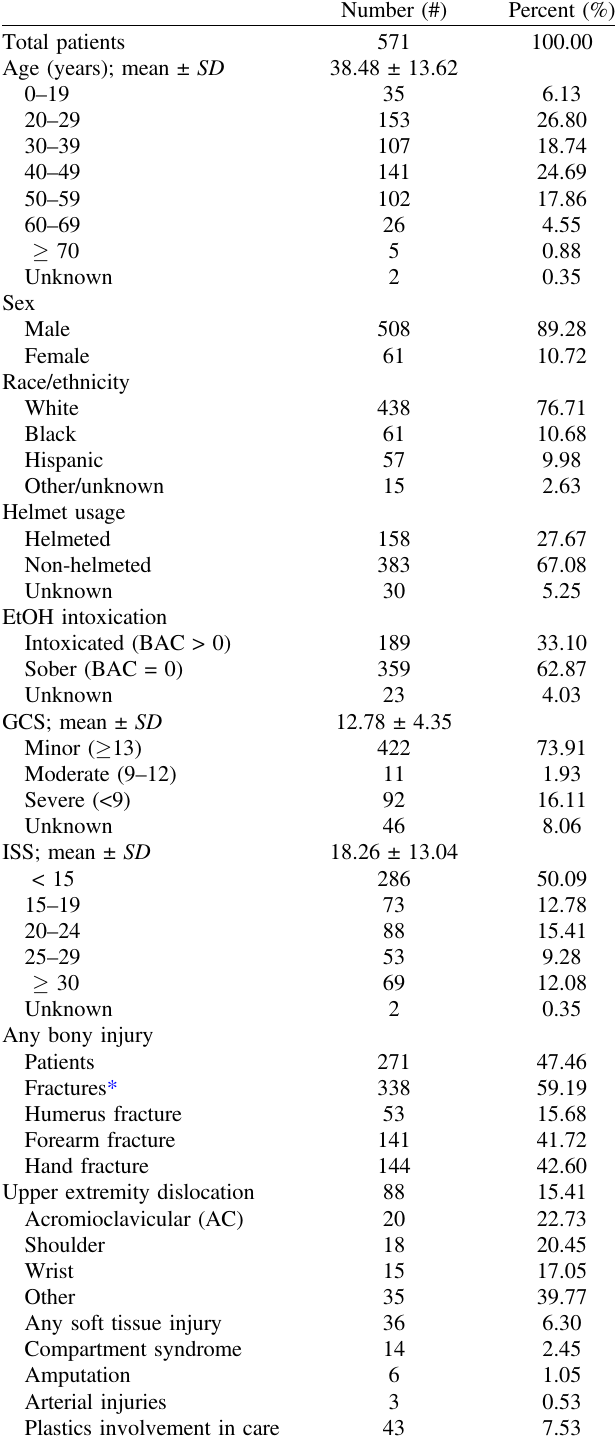
Table 2. Impact of helmet usage on distribution of upper extremity fractures.